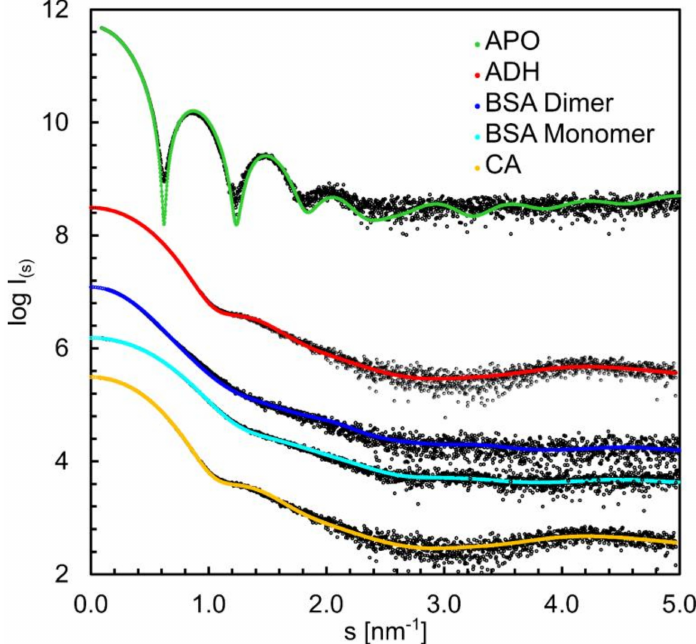
Figure 6. Validation of atomistic structures in solution. Final I(s) vs. s scattering curves are fitted by the theoretical scattering curves of available pdb structures. Subtracted SAXS profiles shown in log-linear plot and shifted along the y-axis for better visibility. PDB files and resulting χ 2 values are listed